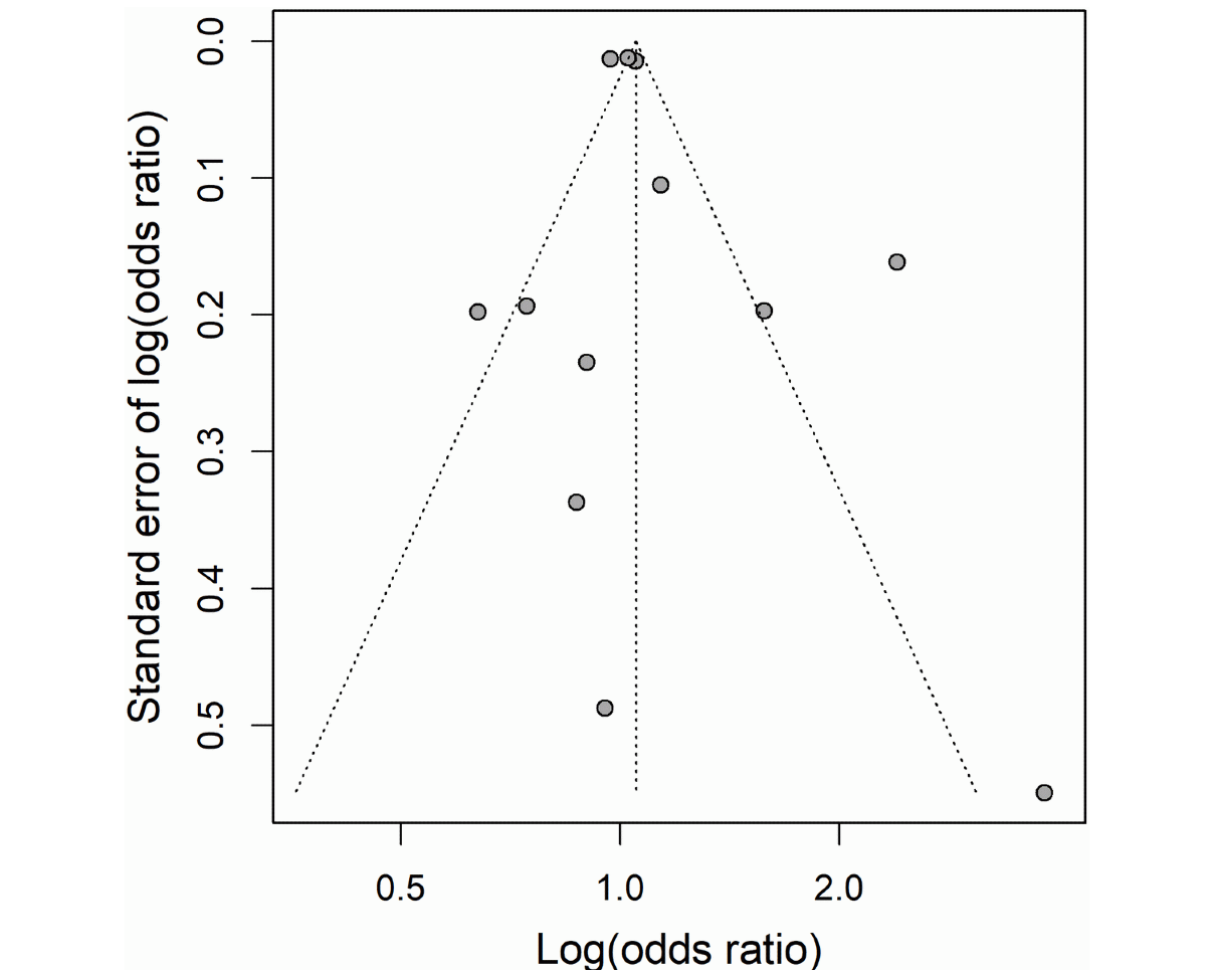
Figure 2. Funnel plot with pseudo 95% confidence limit for cross-sectional